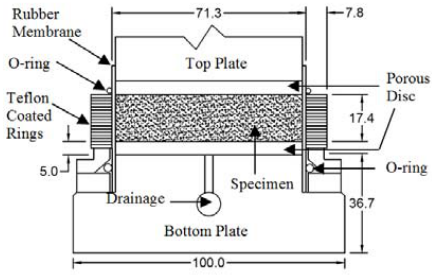
Figure 2. Sectional details of a specimen in a mould [52].